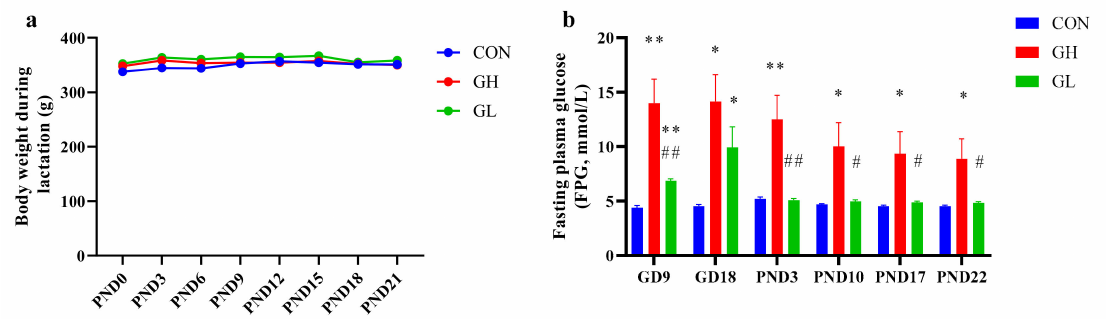
Figure 3. The body weight and FPG during lactation period. ( a ) The maternal body weight during lactation. ( b ) The fasting plasma glucose during pregnancy and lactation. * significant differences vs. CON group, p < 0.05. ** significant differences vs. CON group, p < 0.01. # significant differences vs. GH group, p < 0.05. ## significant differences vs. GH group, p < 0.01.